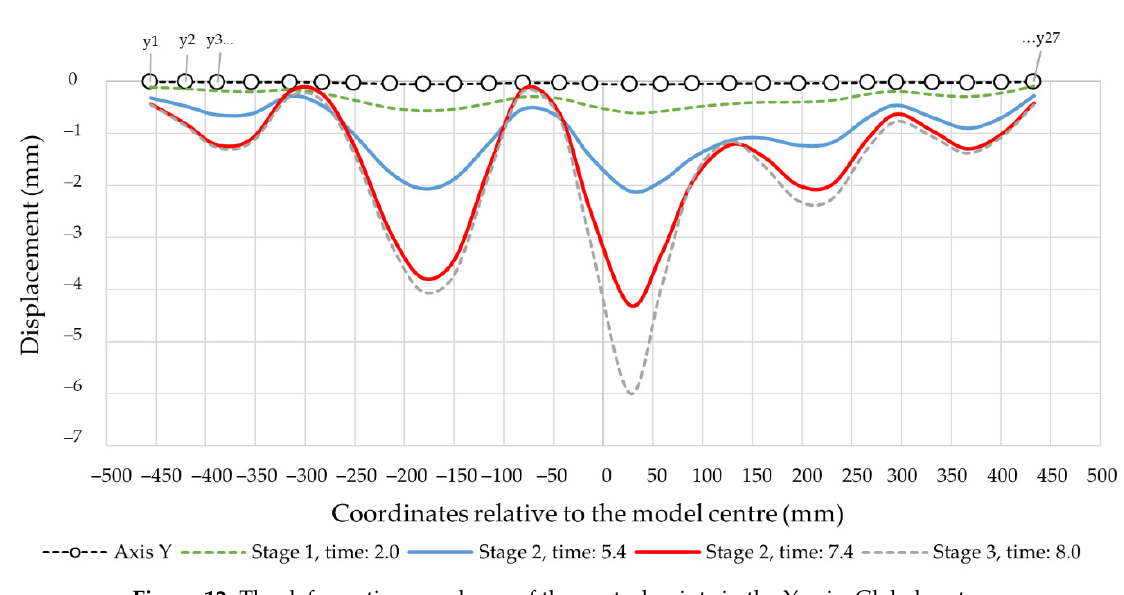
Figure 12. The deformation envelopes of the control points in the Y-axis. Global system.